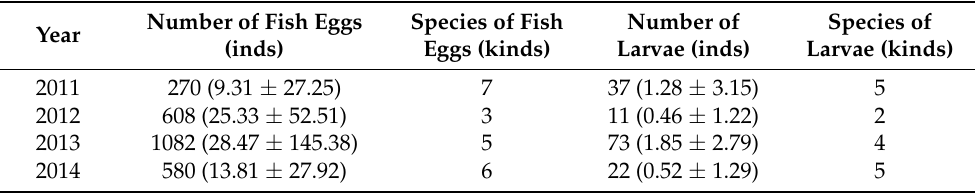
Table 3. Variation in the abundances of fish eggs and